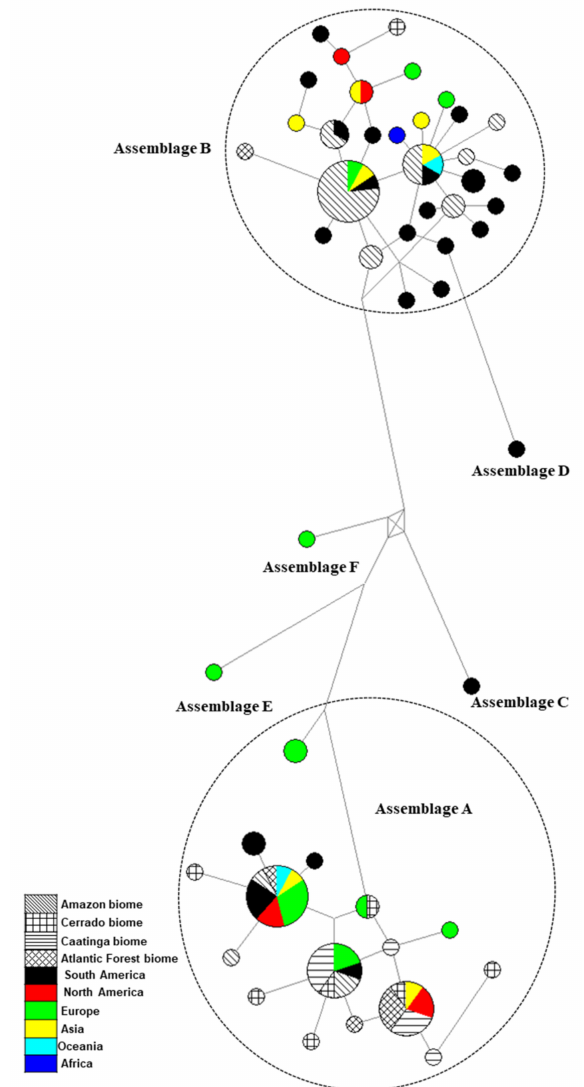
Figure 3. Haplotype network based on Giardia duodenalis β -giardin locus (592 bp, n = 106). Area of the circle is proportional to number of sequences. Further details of reference strains can be found in Supplementary Table